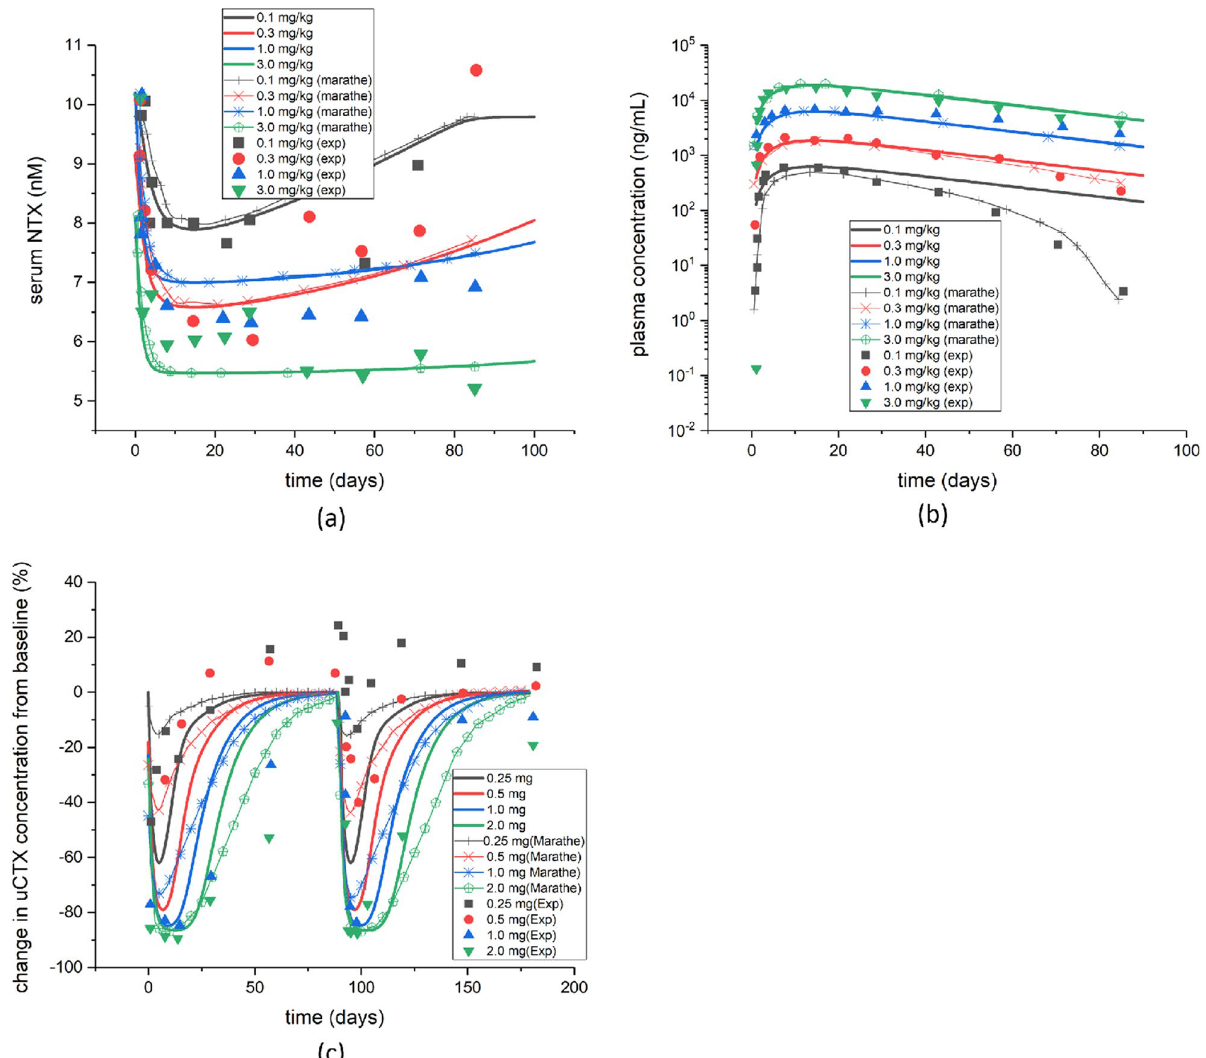
Figure 1. ( a ) Evolution of the serum NTX concentration after administration of a single dose of denosumab and comparison with Marathe’s work 33 and with experiments 36 ; ( b ) evolution of the plasma concentration after administration of a single dose of denosumab and comparison with Marathe’s work 33 and with experiments 36 ; ( c ) changes in the concentration of urine CTX from the baseline after administration of a single dose of Ibandronate and comparison with Marathe’s work 8 and with experiments 35 dosage. This reduction is slowly recovered from 55 to 95 % of the initial baseline, in 80 days, depending on the dose. That initial decrease is higher for higher doses, although the difference between doses of 0.3 and 1 mg/kg is small. On the contrary, the plasma concentration increases by orders of magnitude in the first days after drug administration, with subsequent recovery towards the initial baseline. Figure 1c shows the evolution of uCTX concentration after intravenous administration of Ibandronate for 180 days and an interval between successive doses of 90 days. The concentration of uCTX shows a strong reduction in the first days after drug administration, up to values of 80 % of reduction for a dose of 2 mg of Ibandronate. Then the concentration starts to rise towards its initial baseline, which is reobtained at about 90 days after drug administration. All these results are in good agreement with those presented in other studies 8,33,35,36 . 0.5g / cm 3 , The evolution of the bone volume fraction (Eq. (2)) for different bone types (osteoporotic, ρ = 0 ), equilibrium trabecular, 1.0g / cm 3 , and cortical, 2.05g / cm 3 ) under different mechanical stimuli of disuse ( ξ = ξ ∗ ), overload ( ξ 5 ξ ∗ ) and high-overload ( ξ 7 ξ ∗ ), with ξ ∗ denoting the reference stimulus (Eq. (7)) are ( ξ = = = depicted in Fig. 2. The initial values are obtained by solving the stationary state of Eq. (1), i.e without considering ξ ∗ ). When increasing the drug dose, the volume fraction the drug effect and under equilibrium stimulus ( ξ = 1.0g / cm 3 , the maximum increase of volume fraction in the equilibrium increases for all types of bone. For ρ = condition with respect to the control case for 0.1, 0.3, 1.0 and 3.0 mg/kg of denosumab was about 16%, 32%, 53% and 107% respectively, while for 0.25, 0.5, 1.0 and 2.0 mg of Ibandronate these increases were 15%, 27%, 46% and 90% respectively.